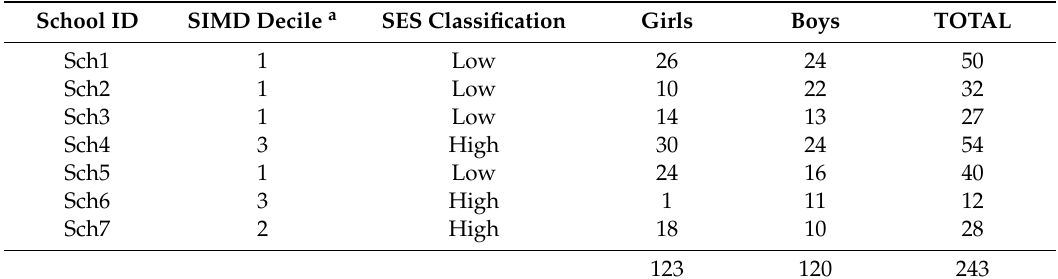
Table 1. Participating schools in terms of the Scottish Index of Multiple Deprivation (SIMD)